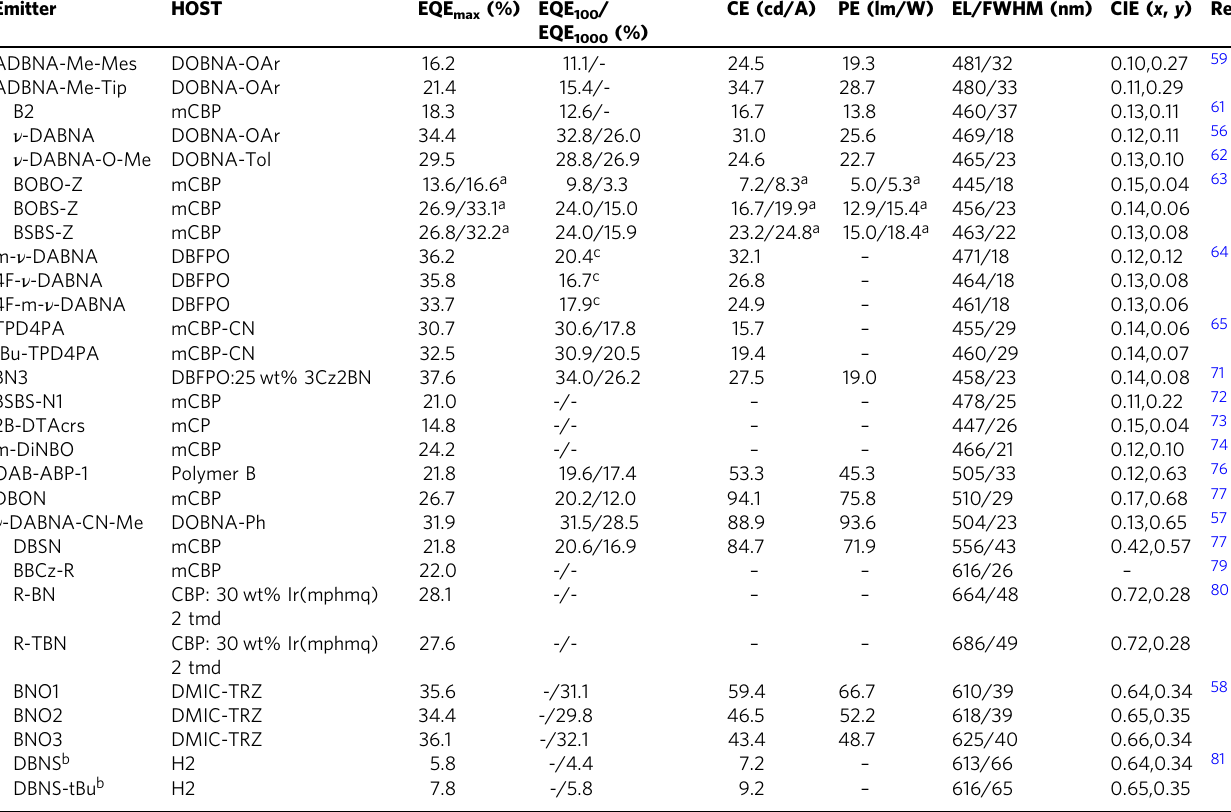
Table 2 Detailed device characteristics of DB-MR-TADF emitters.